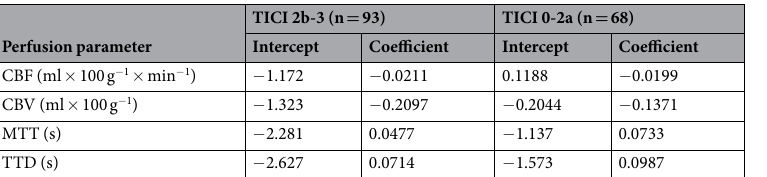
Table 3. Logistic regression coefficients of perfusion